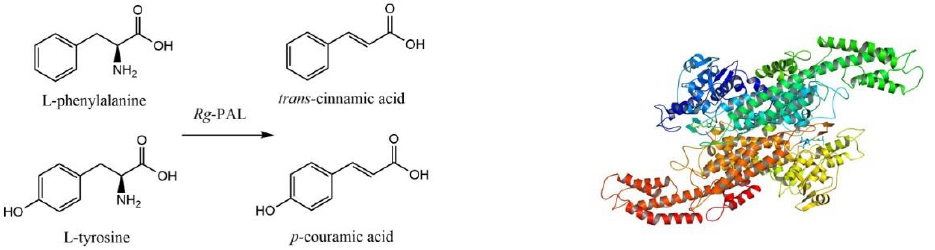
Figure 1. Reactions catalyzed by Rg -PAL.